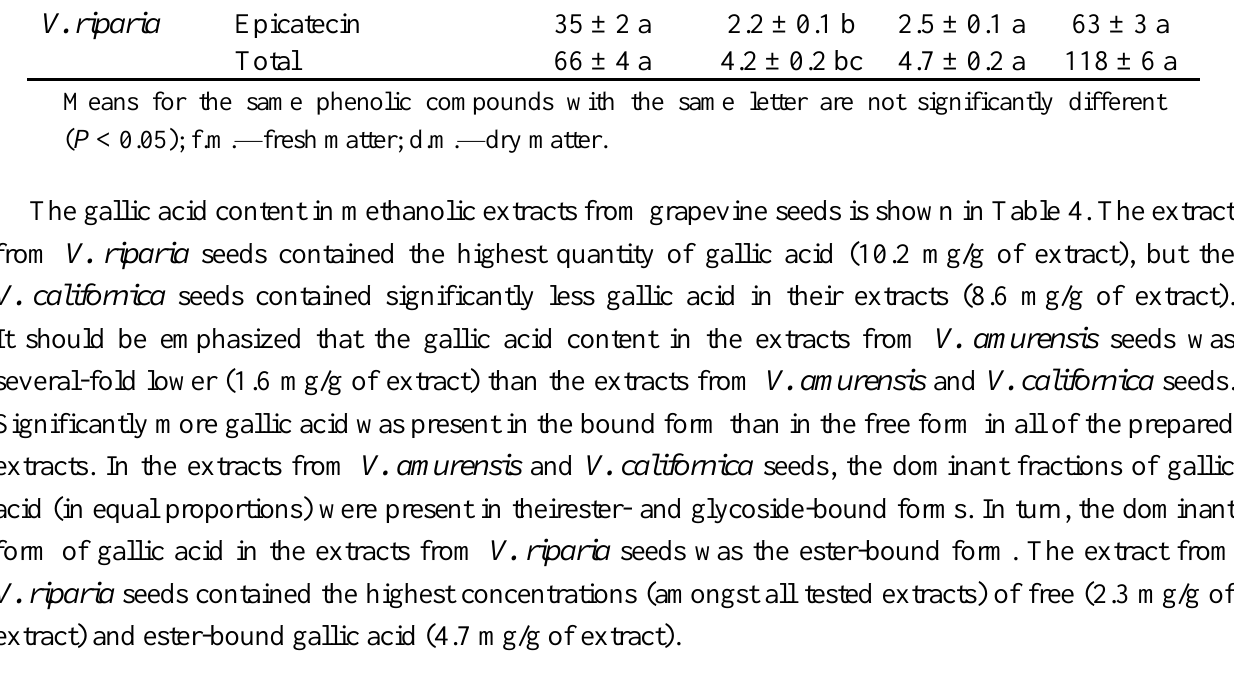
Table 4. Content of gallic acid in the methanolic extracts and